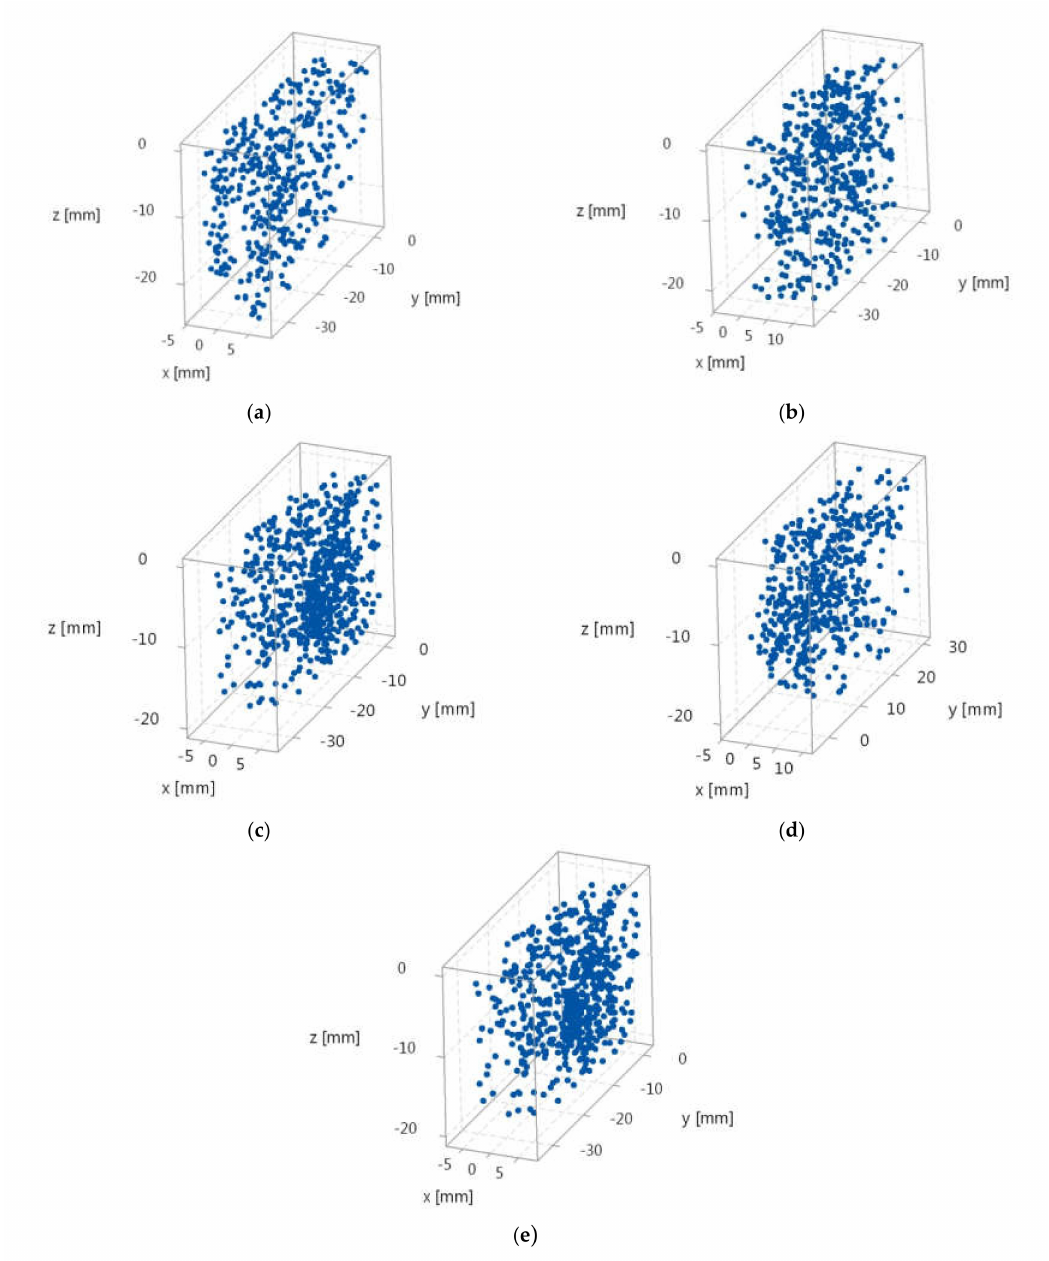
Figure 13. The 3D distribution of the pores x, y, and z are the coordinates of the circumscribed sphere center of the pore: ( a ) sample S1; ( b ) sample S2; ( c ) sample S3; ( d ) sample S4; ( e ) sample S5. The scatter plots of the pores, as well as the distributions in two dimensions using histograms, are shown in Figure 14a–c. The scatter plots show a homogeneous distribution of the pore volume on the X, Y, and Z axes. The distribution has a volume cluster between 0.01 and 0.1 mm 3 . Outliers indicate a singular pore volume greater than 0.1 mm 3 . Similar distributions of pore volume versus X, Y, and Z coordinates were found for all the